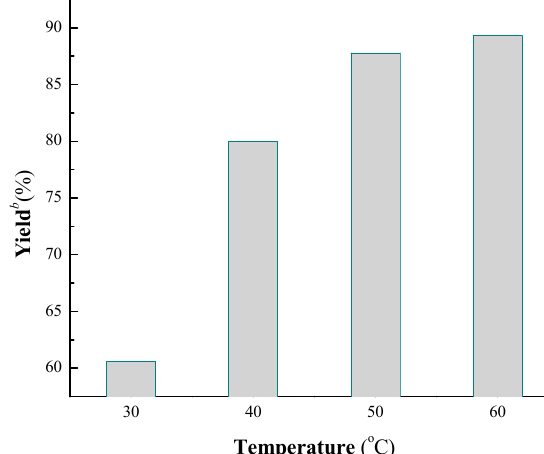
Figure 2. The influence of temperature on the cascade reaction a